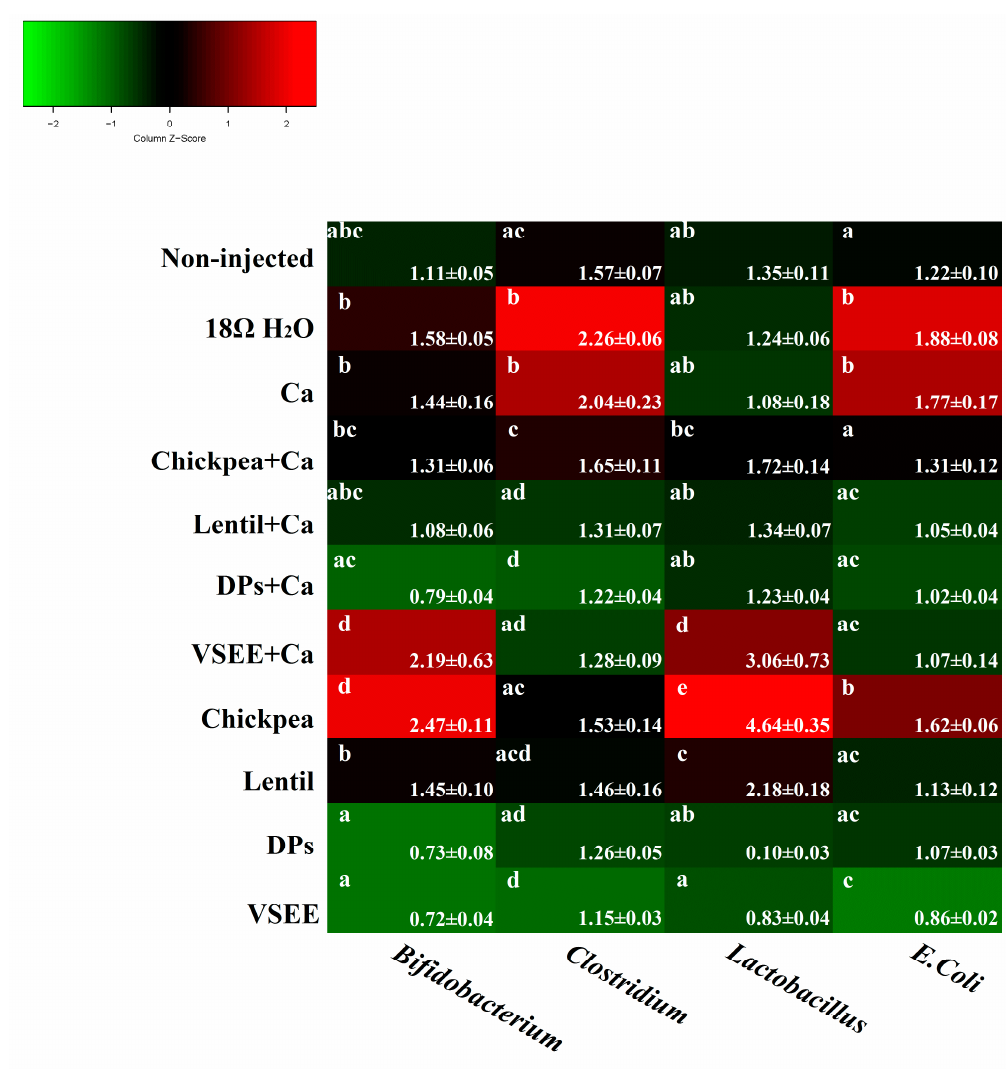
Figure 3. Genera and species-level bacterial populations (AU) from cecal contents measured on the day of hatch. Values are means ± SEM, n = 8. a–d Per bacterial category, treatment groups not indicated by the same letter are significantly different ( p < 0.05).